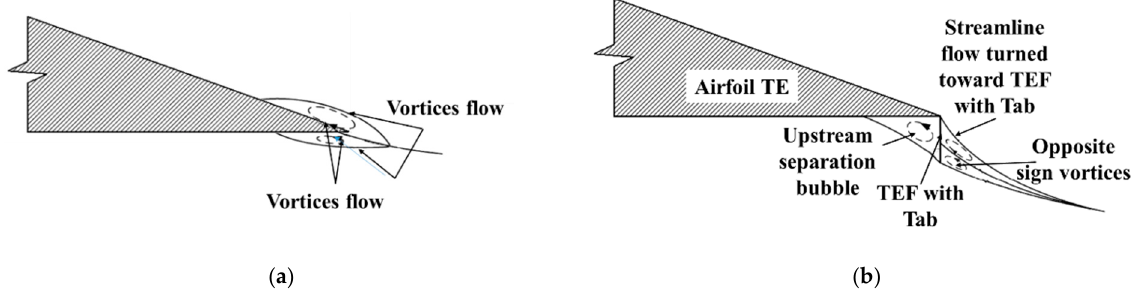
Figure 1. Aerodynamic performance for the streamline over the Micro-Tabs [15]. ( a ) Streamline over the standard airfoil; ( b ) streamline over the standard airfoil with a Micro-Tab.